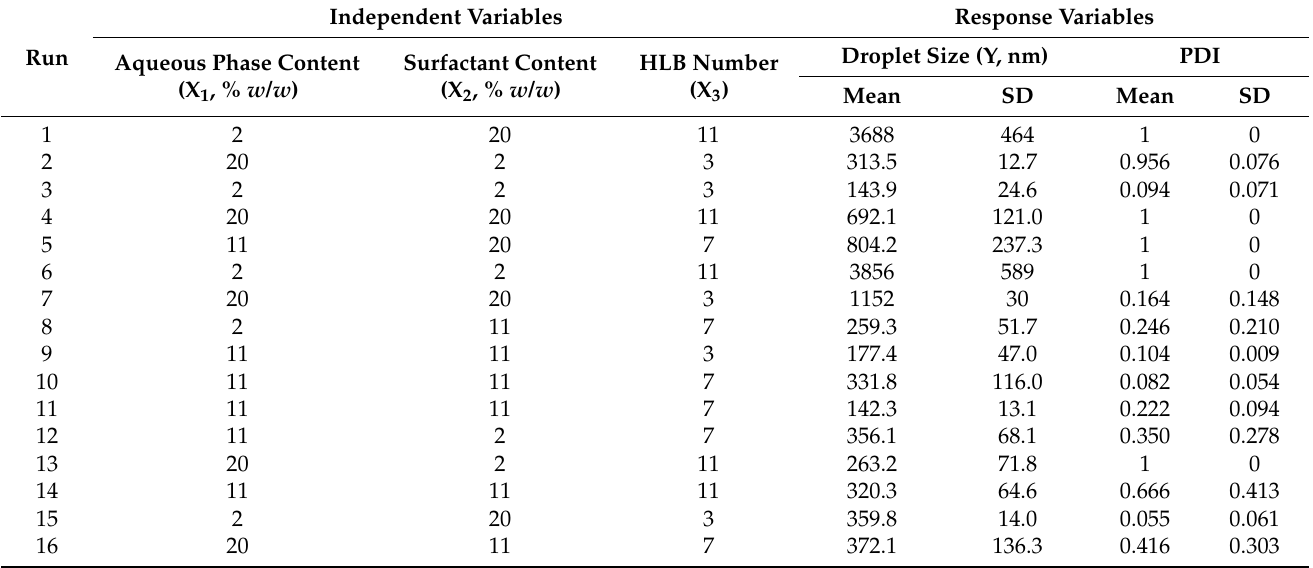
Table 1. Matrix of the CCD and experimental data for the W/O emulsion formulation.